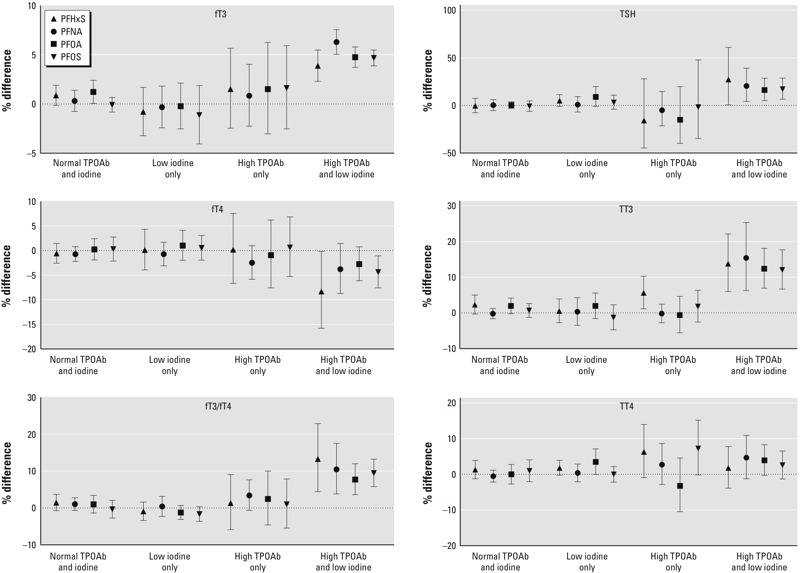
Percent differences in serum thyroid hormone levels for an interquartile ratio increase in Ln serum PFAS concentrations in U.S. adults (NHANES 2007–2008). Results are stratified by TPOAb status (normal < 9; high, ≥ 9 IU/mL serum) and iodine status (normal, ≥ 100; low, < 100 μg/L urine). Error bars represent the 95% CIs. Models are adjusted for age, race, log serum cotinine, sex, parity, pregnancy, and menopause status. Interquartile ratios: 3.2 (PFHxS), 2.1 (PFNA), 2.1 (PFOA), 2.5 (PFOS). PFASs and THs were Ln-transformed in models. Percent differences = [(IQ RatioBeta) – 1] × 100.